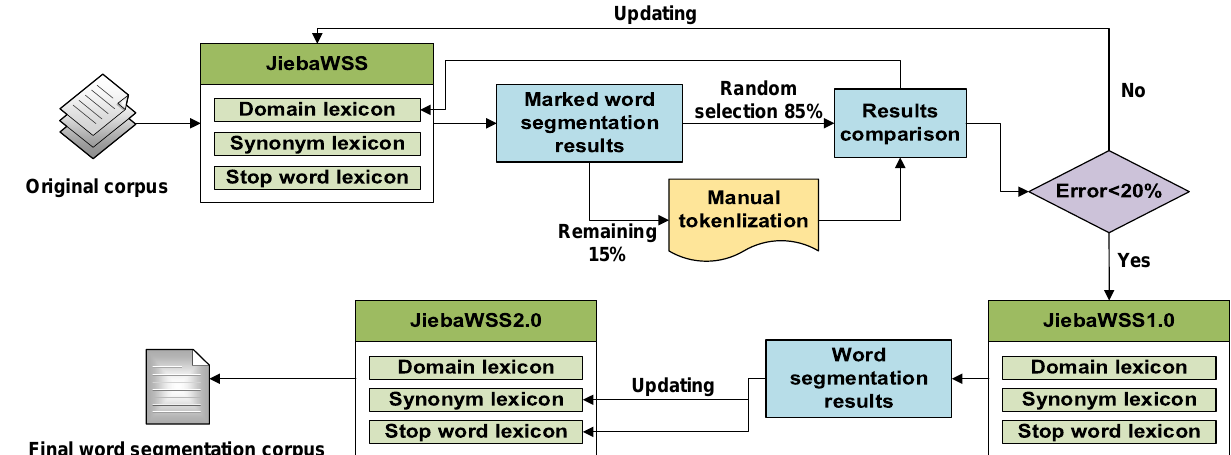
Figure 5. The updated workflow of JiebaWSS.